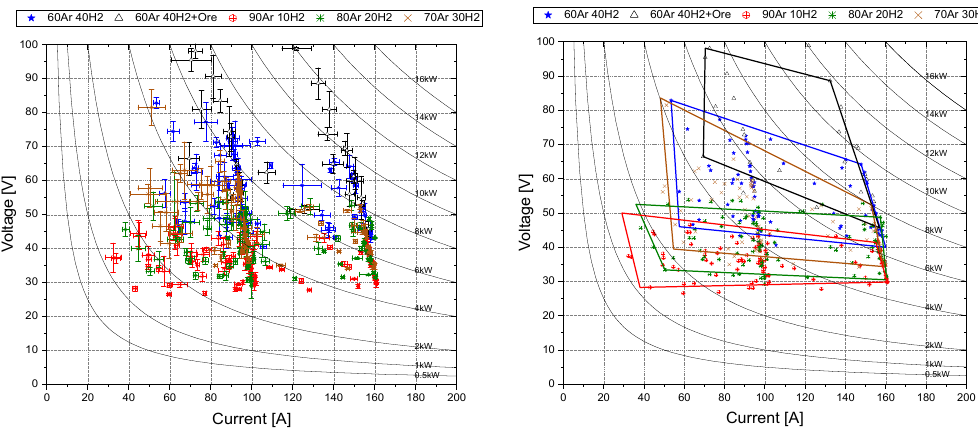
Figure 17. Arc stability fields for the variation of the hydrogen content and the effect of iron ore introduction through the HGE.